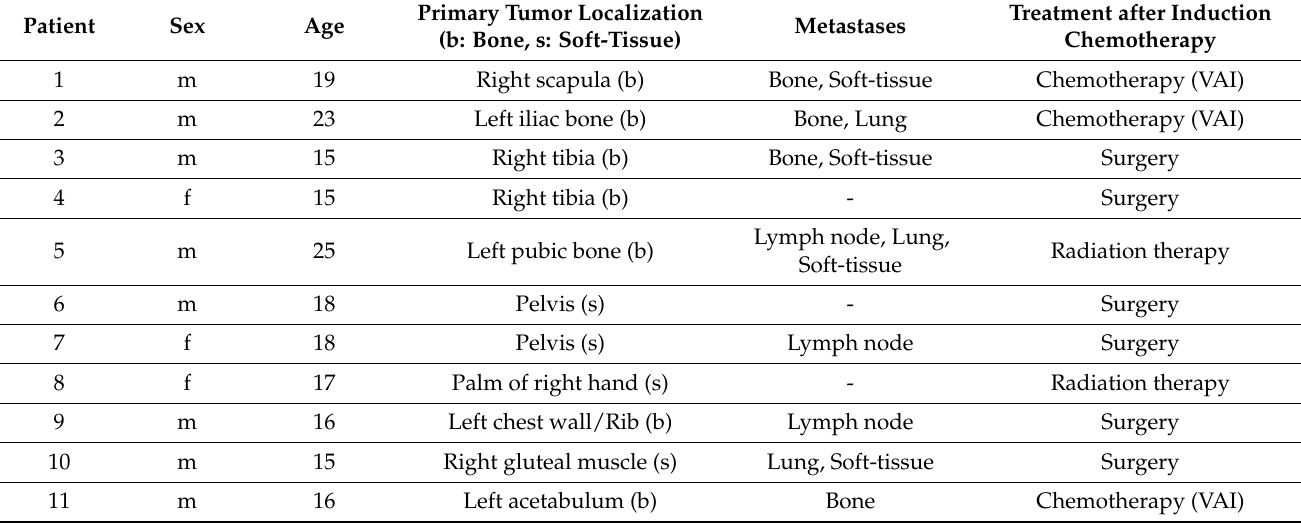
Table 2. Patients’ characteristics.